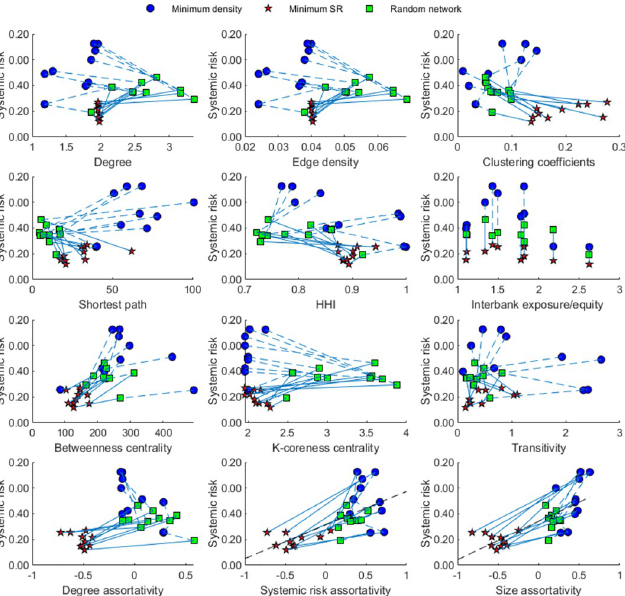
Fig 8. The relationship between systemic risk and network characteristics. The black lines in the figure are the fitted curves. Pearson’s linear correlation coefficients from left to right of the figure are 0.6391 and 0.7285, respectively (P values are all less than 0.01).